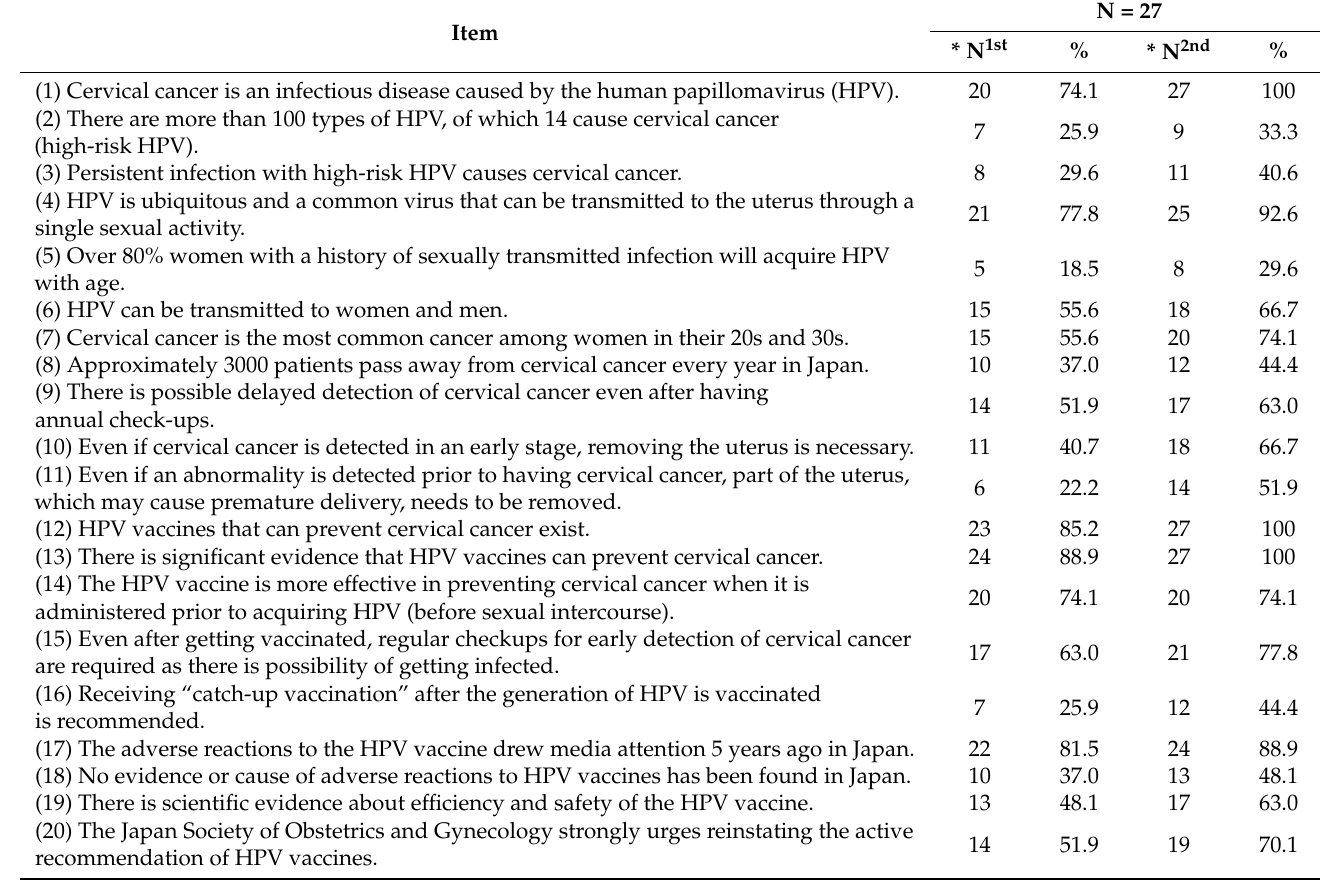
Table 2. Results of the health literacy scale (first and second survey